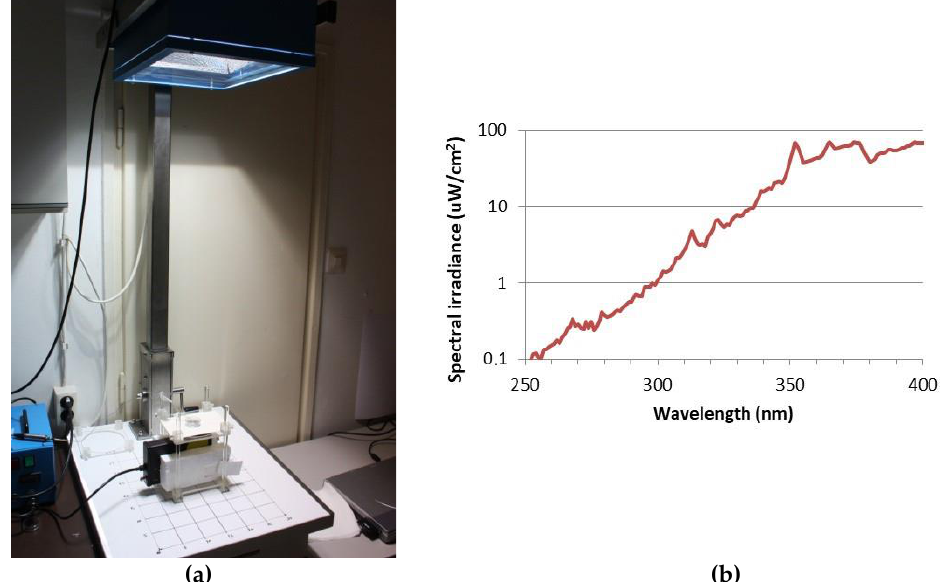
Figure 4. ( a ) Spectral measurement, the UV exposure system of the solar simulator (Hönle SOL-500) equipped with a wavelength filter; ( b ) spectral irradiance of the solar simulator filtered with the lid of a Petri dish.